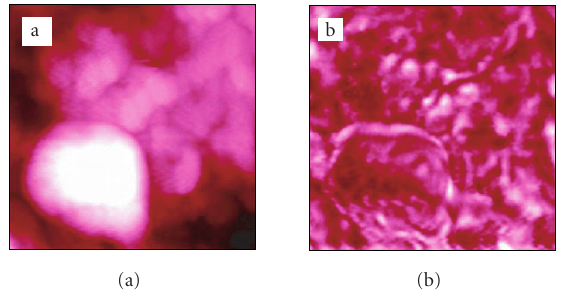
Figure 24: Simultaneous shear-force AFM (a) (5 μ m, Z range 500nm) and SNOM (b): the SNOM image shows both artificial rings at the impossible tube structure site and an interesting chem- ical contrast at the dark triangle extending further